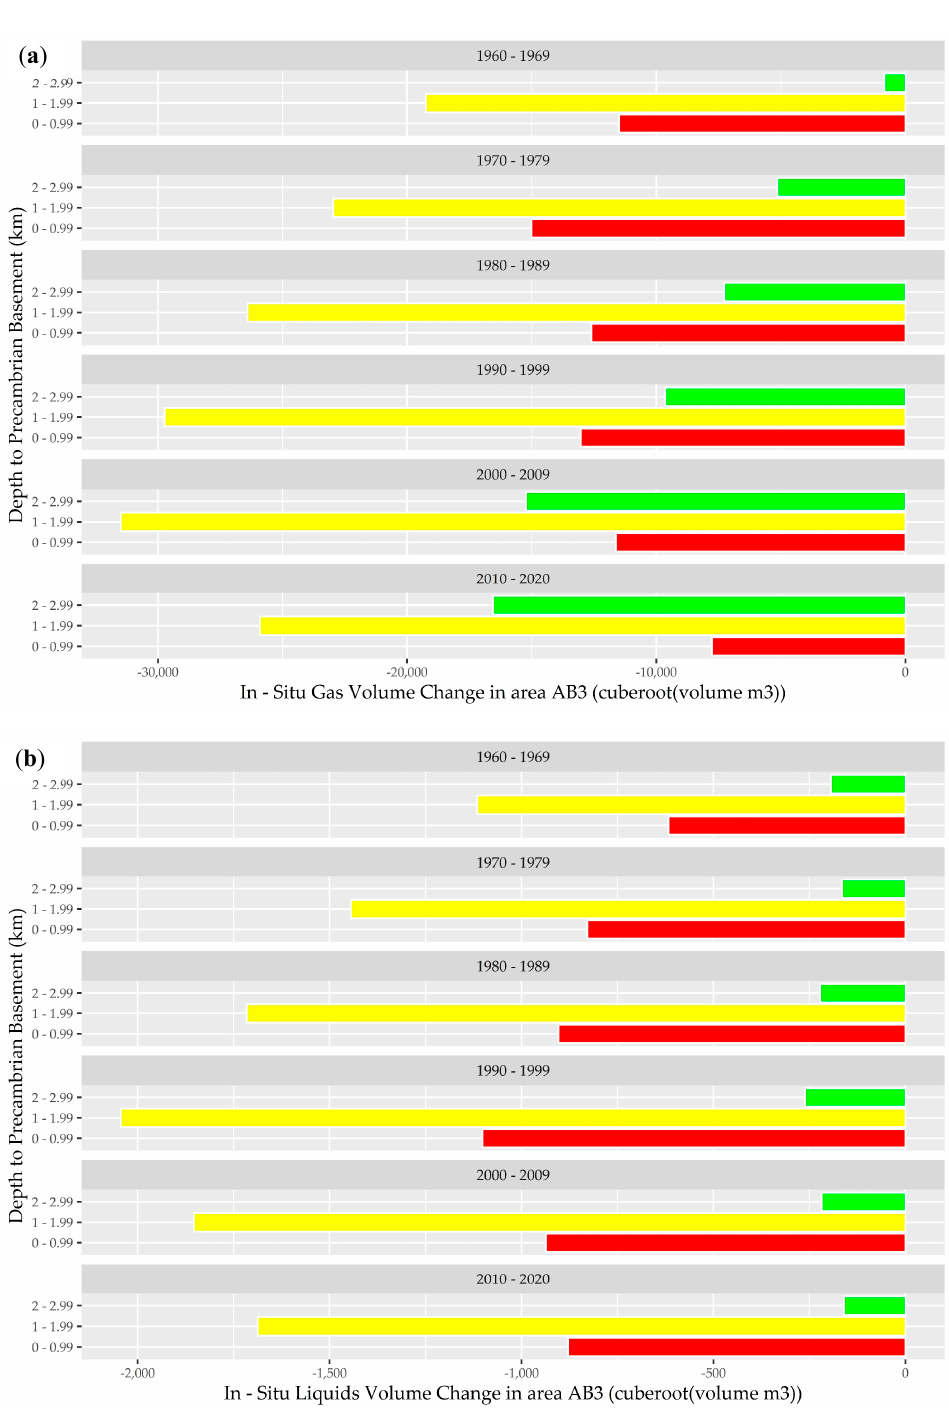
Figure 5. Calculated net in situ ( a ) gas and ( b ) liquid balance for AB3 over the period January 1960–December 2020. Red bars: <1 km depth from Precambrian basement; Yellow bars: 1–2 km depth from Precambrian basement; Green bars: 2–3 km depth from Precambrian basement. Source data extracted from geoLOGIC Systems databases ©